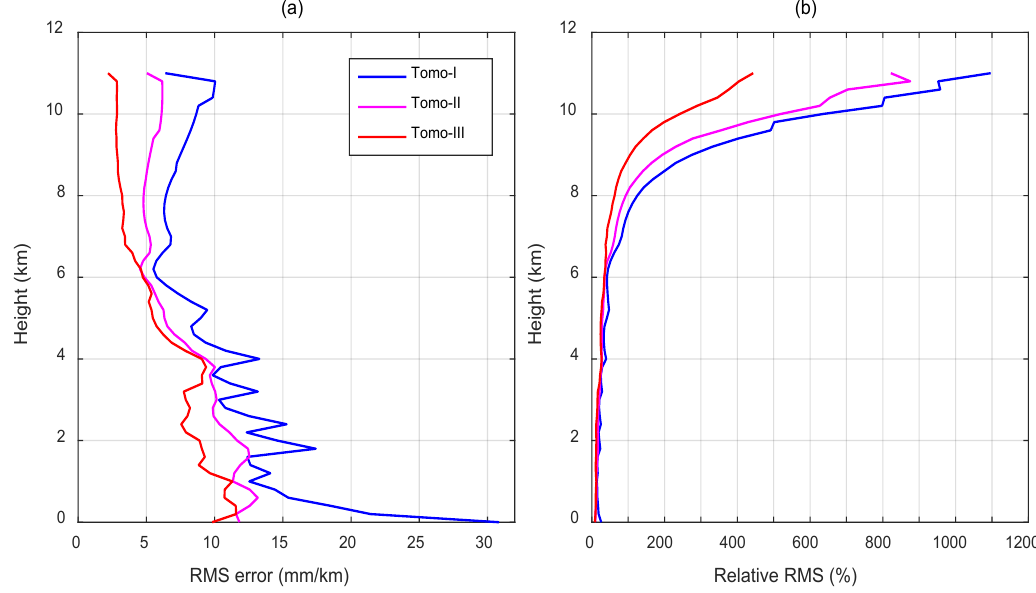
Figure 5. ( a ) RMS errors and ( b ) relative RMS of the differences between the wet refractivity profiles derived from radiosonde and tomography on the different altitude layers.